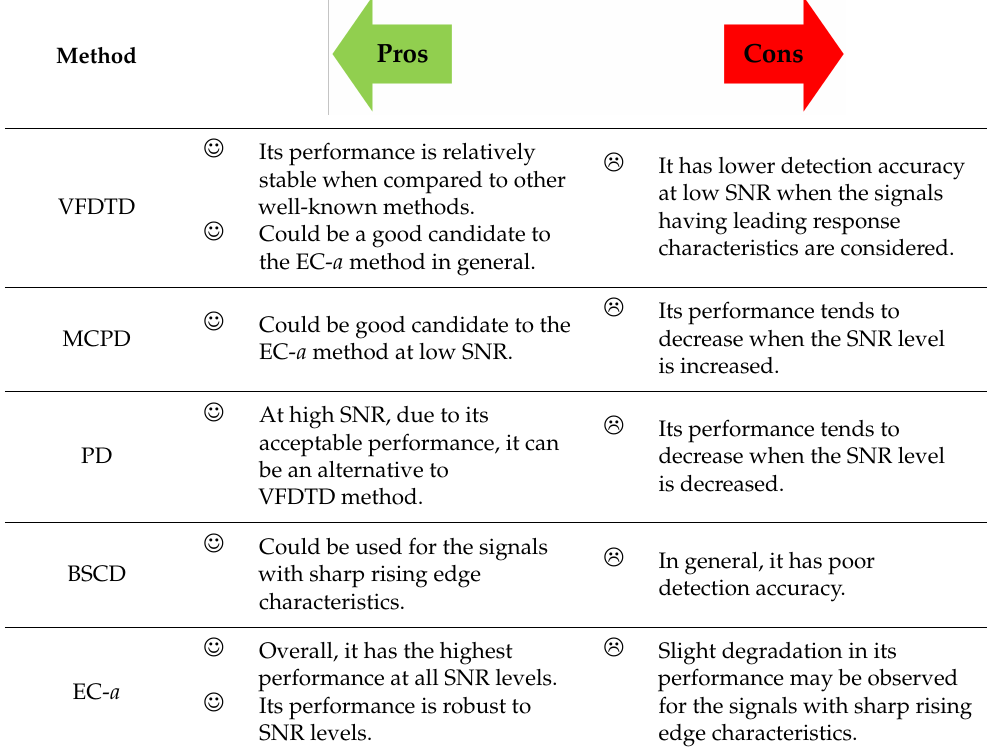
Table 5. Comparison of the transient start detection methods based on the experimental results.